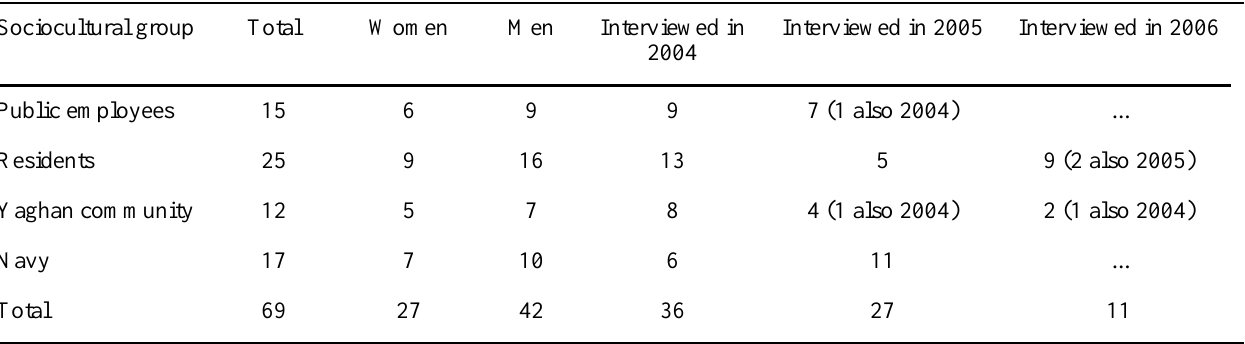
Table 1 . Respondents according to sociocultural groups and year of interview. Sociocultural